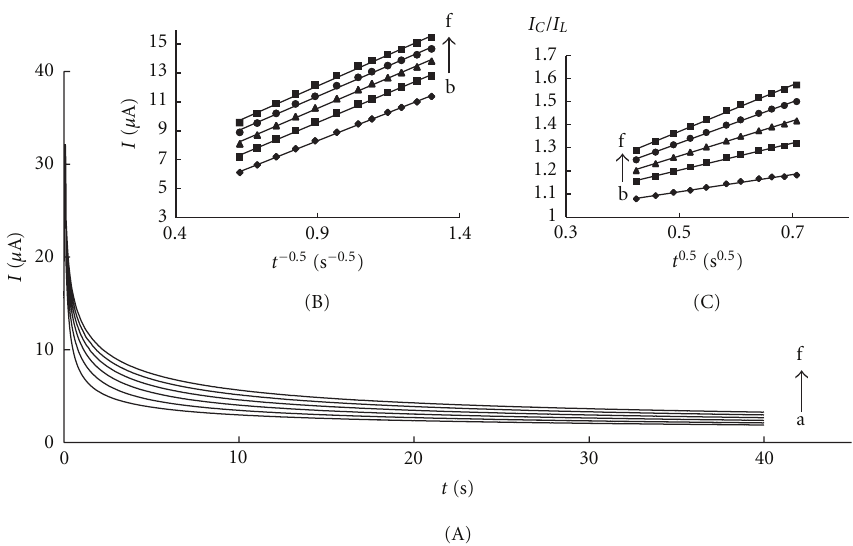
Figure 5: (A) Chronoamperometric responses of a GCE in a phosphate bu ff er solution (pH 4.0, 0.05 M) + 1.50mM CPZ and di ff erent amounts of CAP: a: 0.0mM; b: 0.1 mM; c: 0.2 mM; d: 0.3 mM; e: 0.4 mM; f: 0.5 mM. (B) Plots of currents versus the square root of time elapsed ( t 0 . 5 ) for the chronoamperograms in (A) b to f. (C) Plots of I C /I L versus square root of time elapsed ( t 0 . 5 ) for the chronoamperograms in (A) b to f. The step potential was +0.850 V versus SCE.